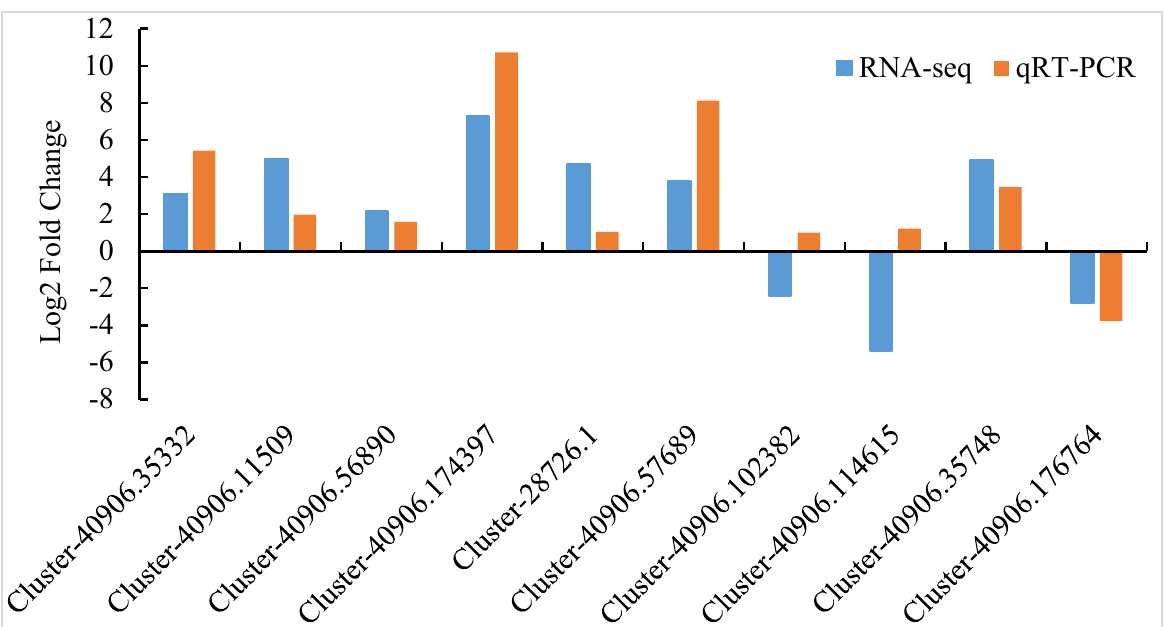
Figure 6. Comparison of qRT-PCR and RNA-seq results of 10 candidate genes in N. tangutorum .